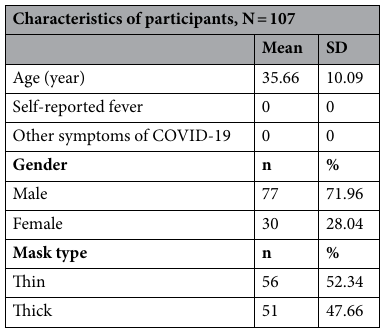
Table 2. Demographic attributes of